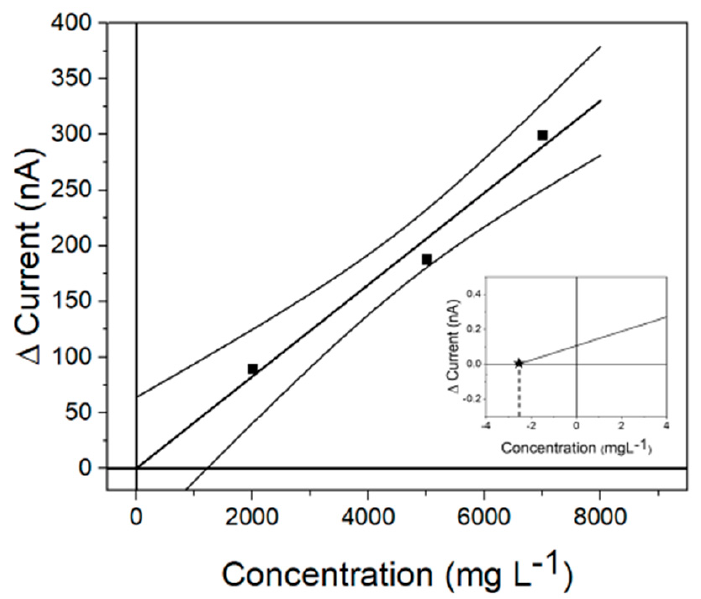
Figure 7. Determination of H 2 O 2 concentration in commercial cow’s milk sample. Experimental calibration curve in matrix and hydrogen peroxide concentration ( ★ ), equal to (2.2 ± 0.9) mg L − 1 , found by Gran’s plot method (see inset). Each point represents the mean of at least three repeated determinations.